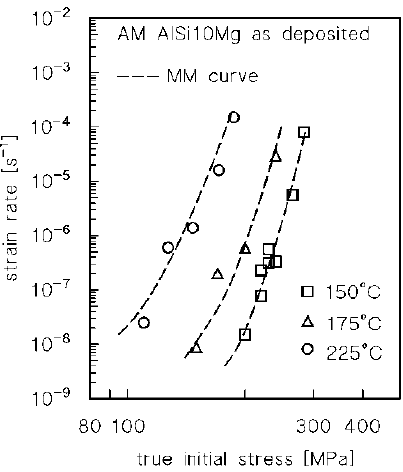
Figure 2. Experimental values of the minimum creep rate in as-deposited additive manufacturing (AM) AlSi10Mg and material model (MM) curves (see Appendixes A and B for the constitutive equations used in combination with the composite model, Equation (11), with d 0 = 50 nm) [14]. Table 1. List of constitutive model parameters.